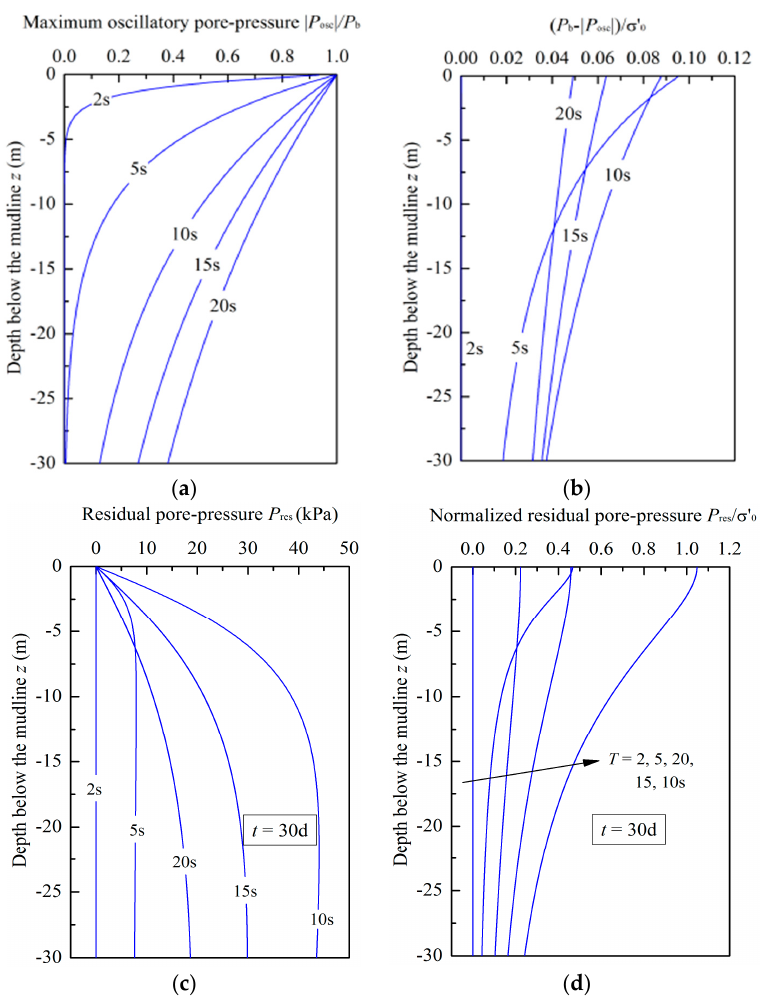
Figure 13. Distributions of the oscillatory pore-pressure and the residual pore-pressure for different wave periods: ( a ) Vertical distribution of | P osc | / P b for different T ; ( b ) vertical distribution of ( P − | P osc | ) / σ (cid:48) for different T ; ( c ) vertical distribution of P res for different T ; ( d ) vertical distribution of b 0 P res / σ (cid:48) for different T . 0